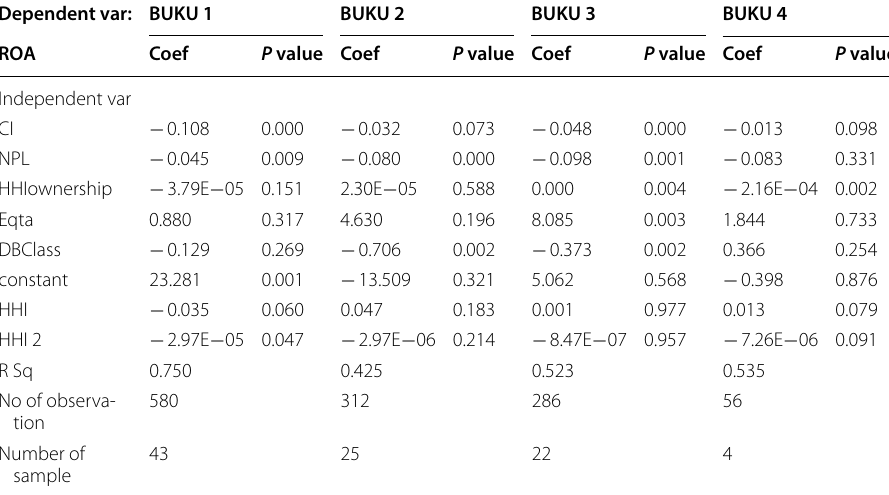
Table 8 Regression result for HHI and profitability relationship for each BUKU.